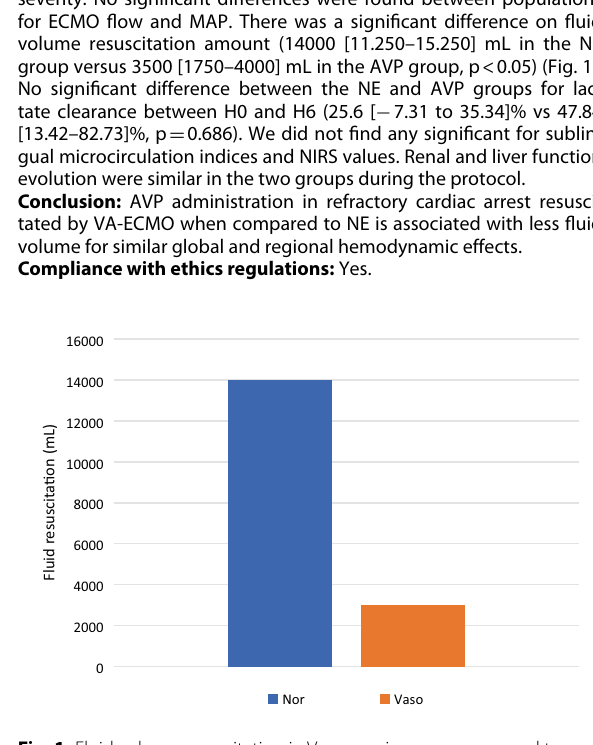
Fig. 1 Fluid volume resuscitation in Vasopressin group compared